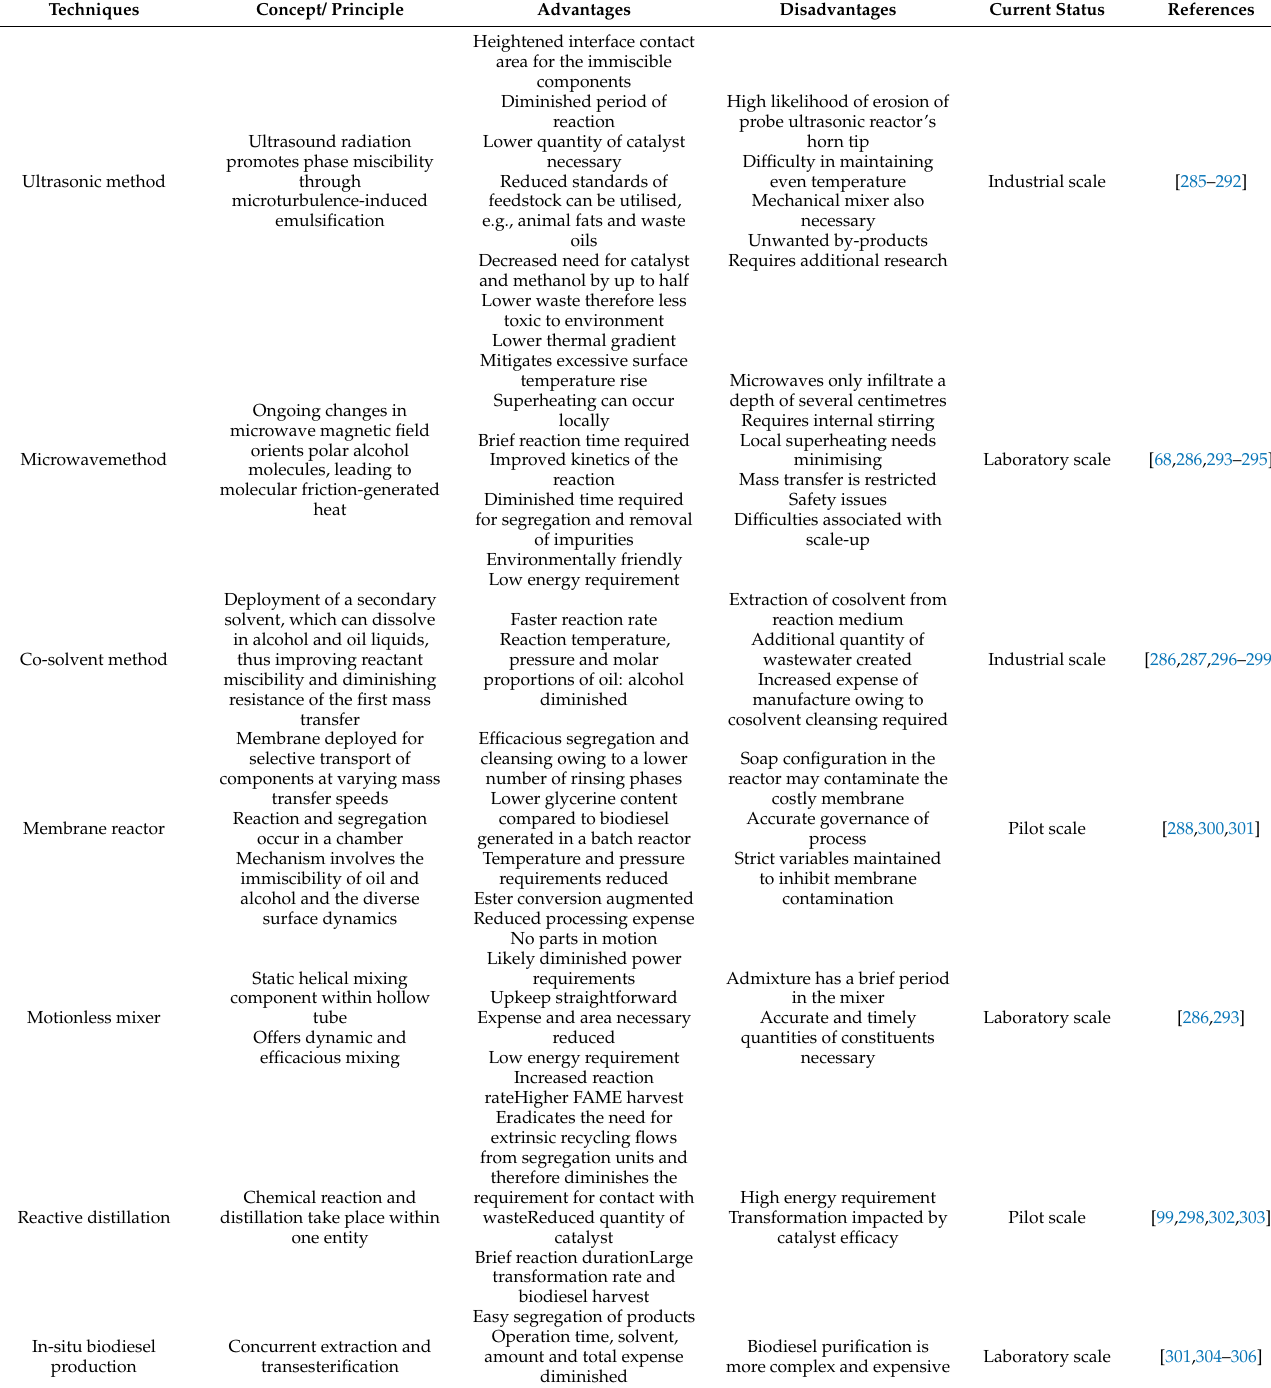
Table 6. Biodiesel production